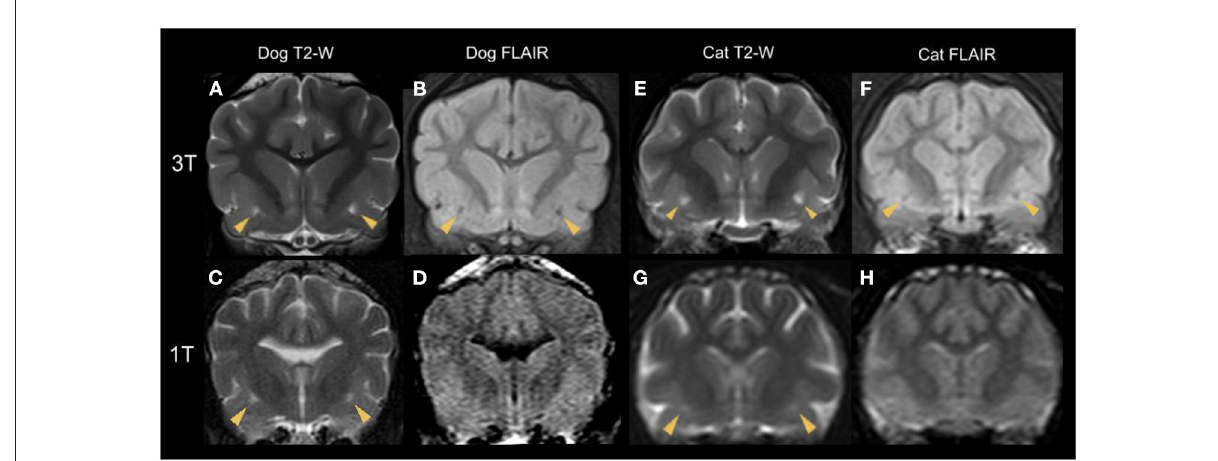
FIGURE5 Transverse plane MR images of various dog (A–D) and cat (E–H) brains at the level of the rostral commissure with bilateral dilated VRS (yellow arrowheads). T2-W (A,C,E,G) and corresponding FLAIR (B,D,F,H) sequences are shown. The top line (A,B,E,F) demonstrates sequences acquired with a 3 Tesla scanner and the bottom line (C,D,G,H) presents 1 Tesla studies. Note the hypointense signal intensity in FLAIR, confirming CSF-isointensity. Due to the decreased image resolution of the 1 Tesla FLAIR studies, the CSF-isointense foci cannot be detected (D,H)